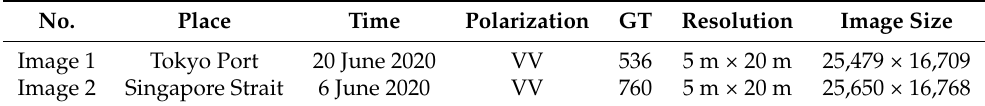
Figure 21. Pd–Pf curves of different methods on SSDD. Table 7. Details of the two large-scene Sentinel-1 SAR